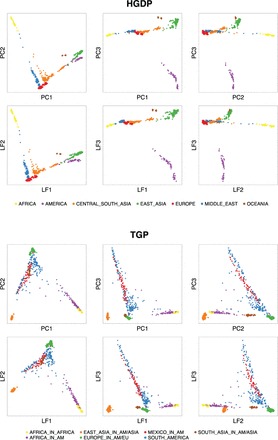
Principal component and logistic factor biplots for the HGDP and TGP datasets. The top three principal components from each dataset are plotted in a pairwise fashion in the top panel. The top three logistic factors are plotted analogously in the bottom panel. It can be seen that both approaches yield similar visualizations of structure